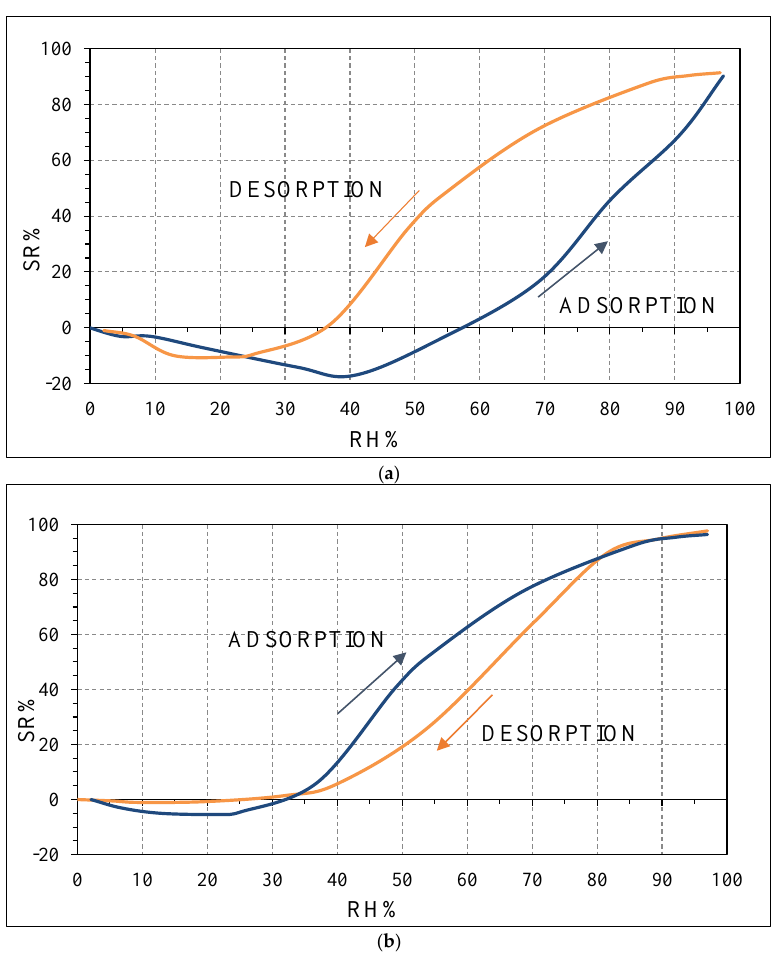
Figure 10. Sensor response towards relative humidity of ( a ) OSR700; ( b ) SWP700 biochars.